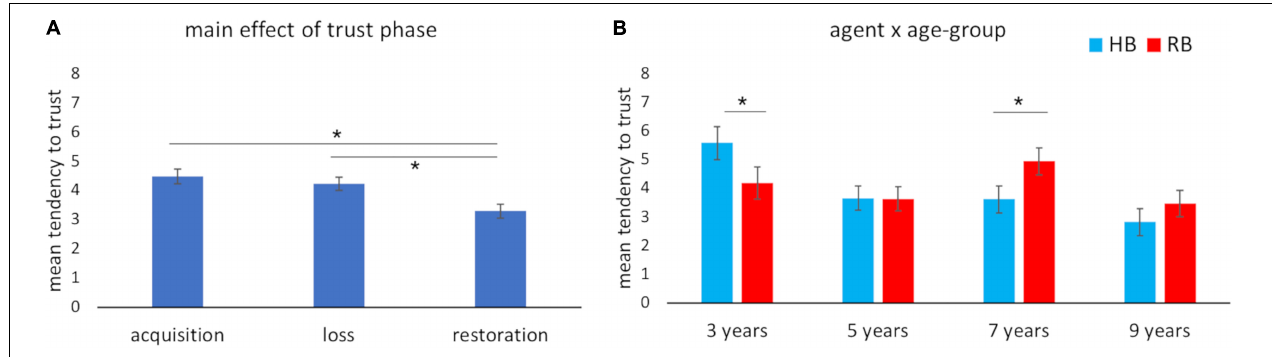
FIGURE 2 | Trust scores for the Trusting Game. Children’s average tendency to trust during the Trusting Game (A) across the three phases of trust (acquisition, loss, and restoration) and (B) across age groups for the human (HB) and the robot (RB) when controlling for the effect of Theory of Mind. The bars represent the standard error of the mean. *indicates significant